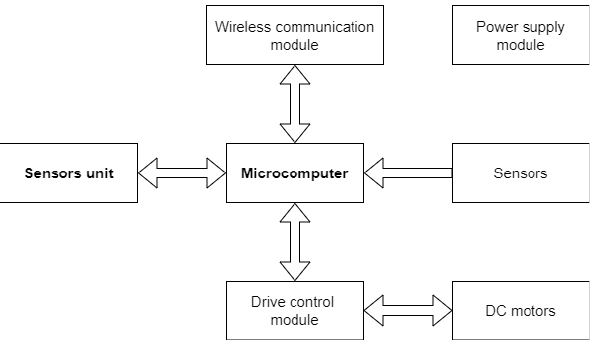
Figure 12. Simple diagram of an Internal Control Unit (ICU).